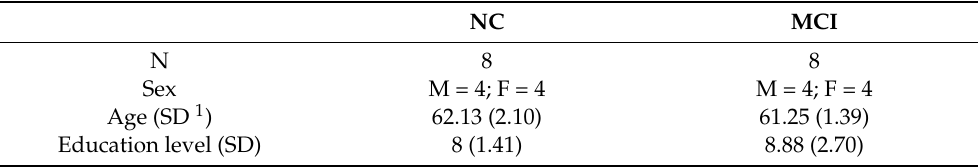
Table 2. Demographic information of the older adults in the cognitively normal (CN) group and the mild cognitive impairment (MCI)